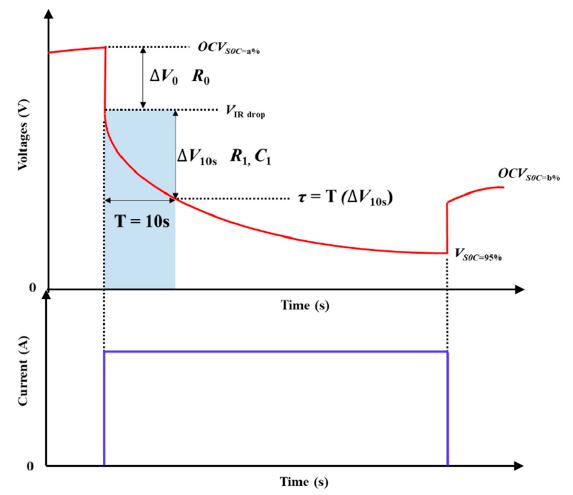
Figure 5. Method of parameter